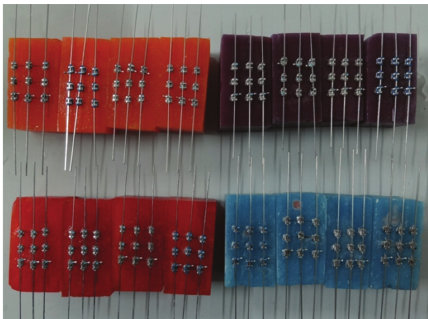
Figure 2: All custom made assemblies with different color coding of acrylic blocks.